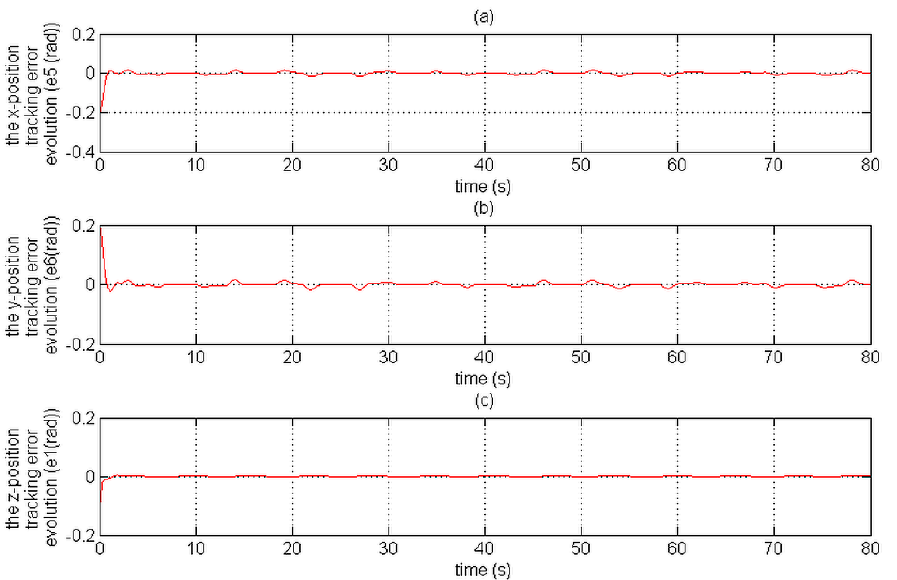
Figure 15. The position tracking errors obtained by the PTCM: ( a ) x -position error (m); ( b ) y -position error (m); ( c ) z -position error (m).